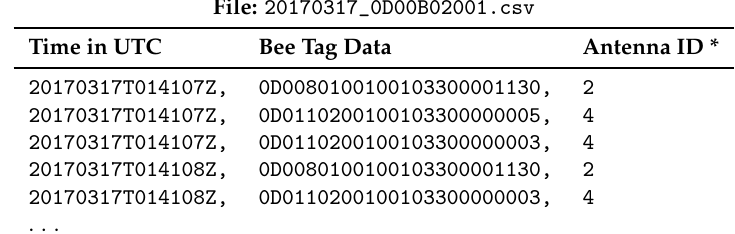
Table 5. The first three lines of sample content in the first file show the detection of three different bees (#1130, #5, #3) on the 17 March 2017 at 1:41:07 (UTC). The second file shows two different bees